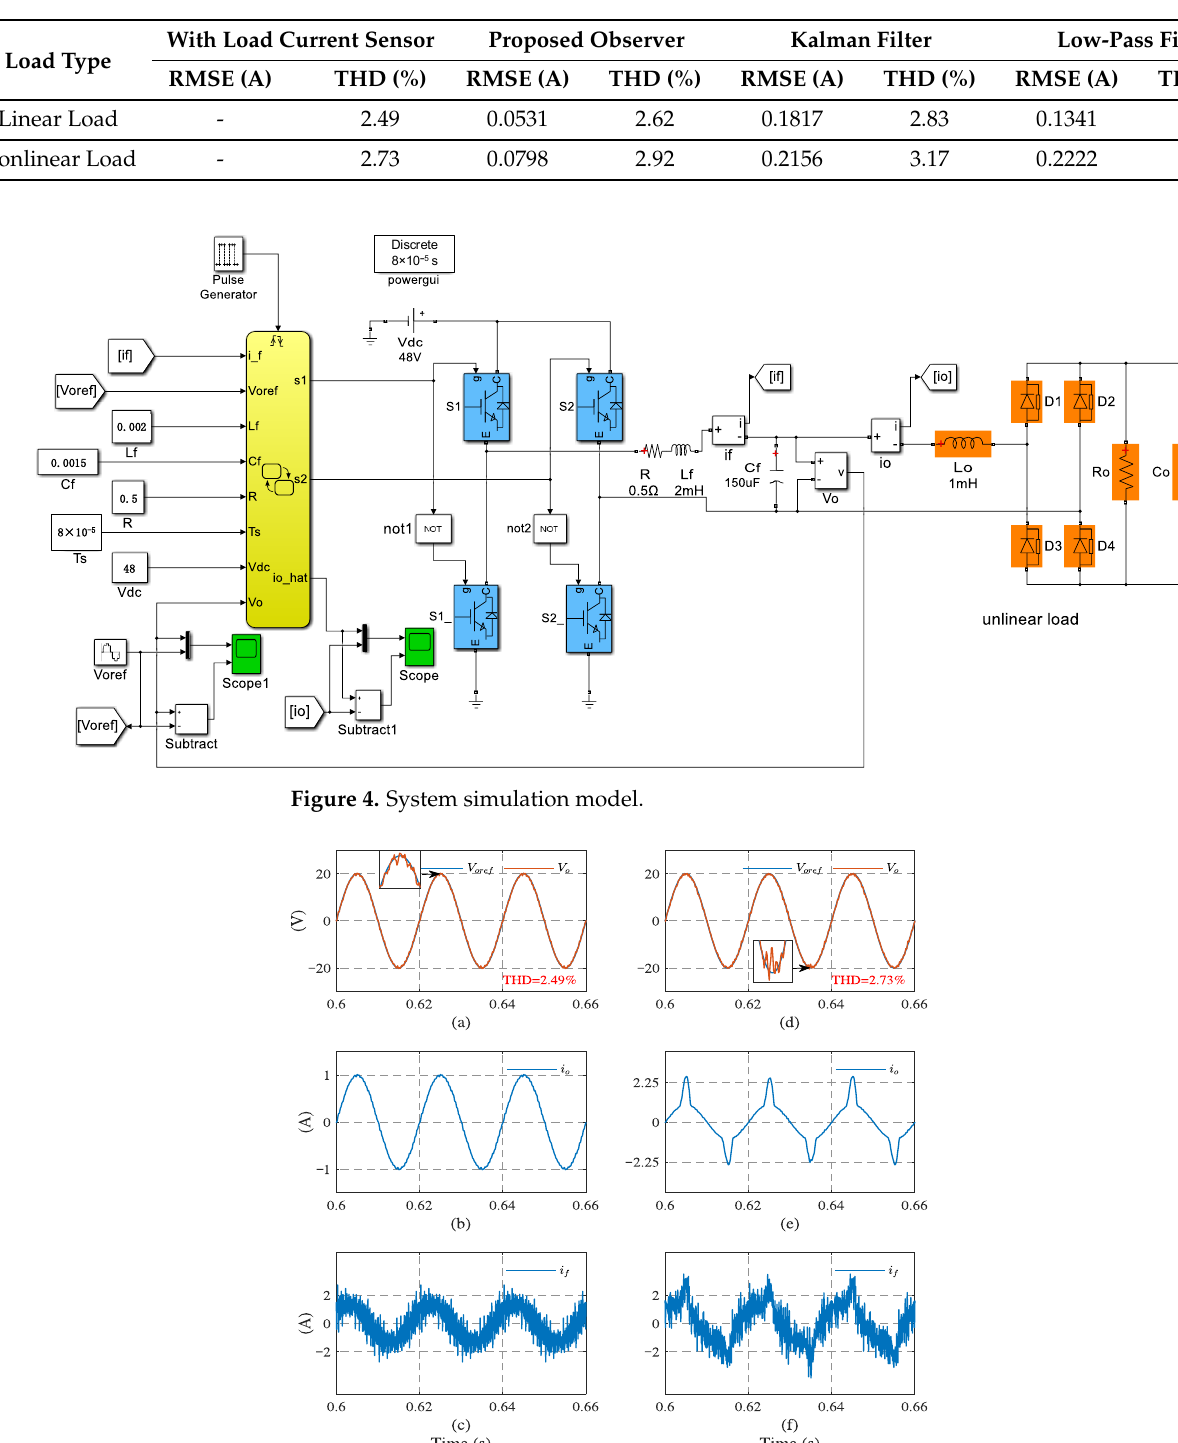
Table 2. Simulation result comparisons of the load current RMSE and output voltage THD, under different loads.